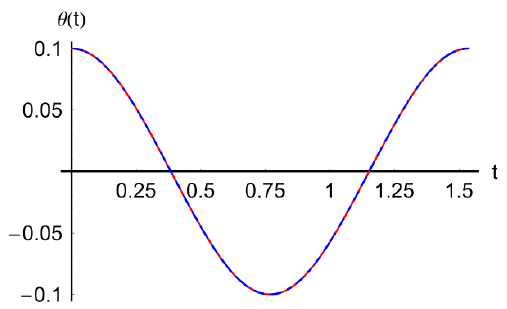
Figure 20. Comparison between the approximate solution (50) and numerical integration results for